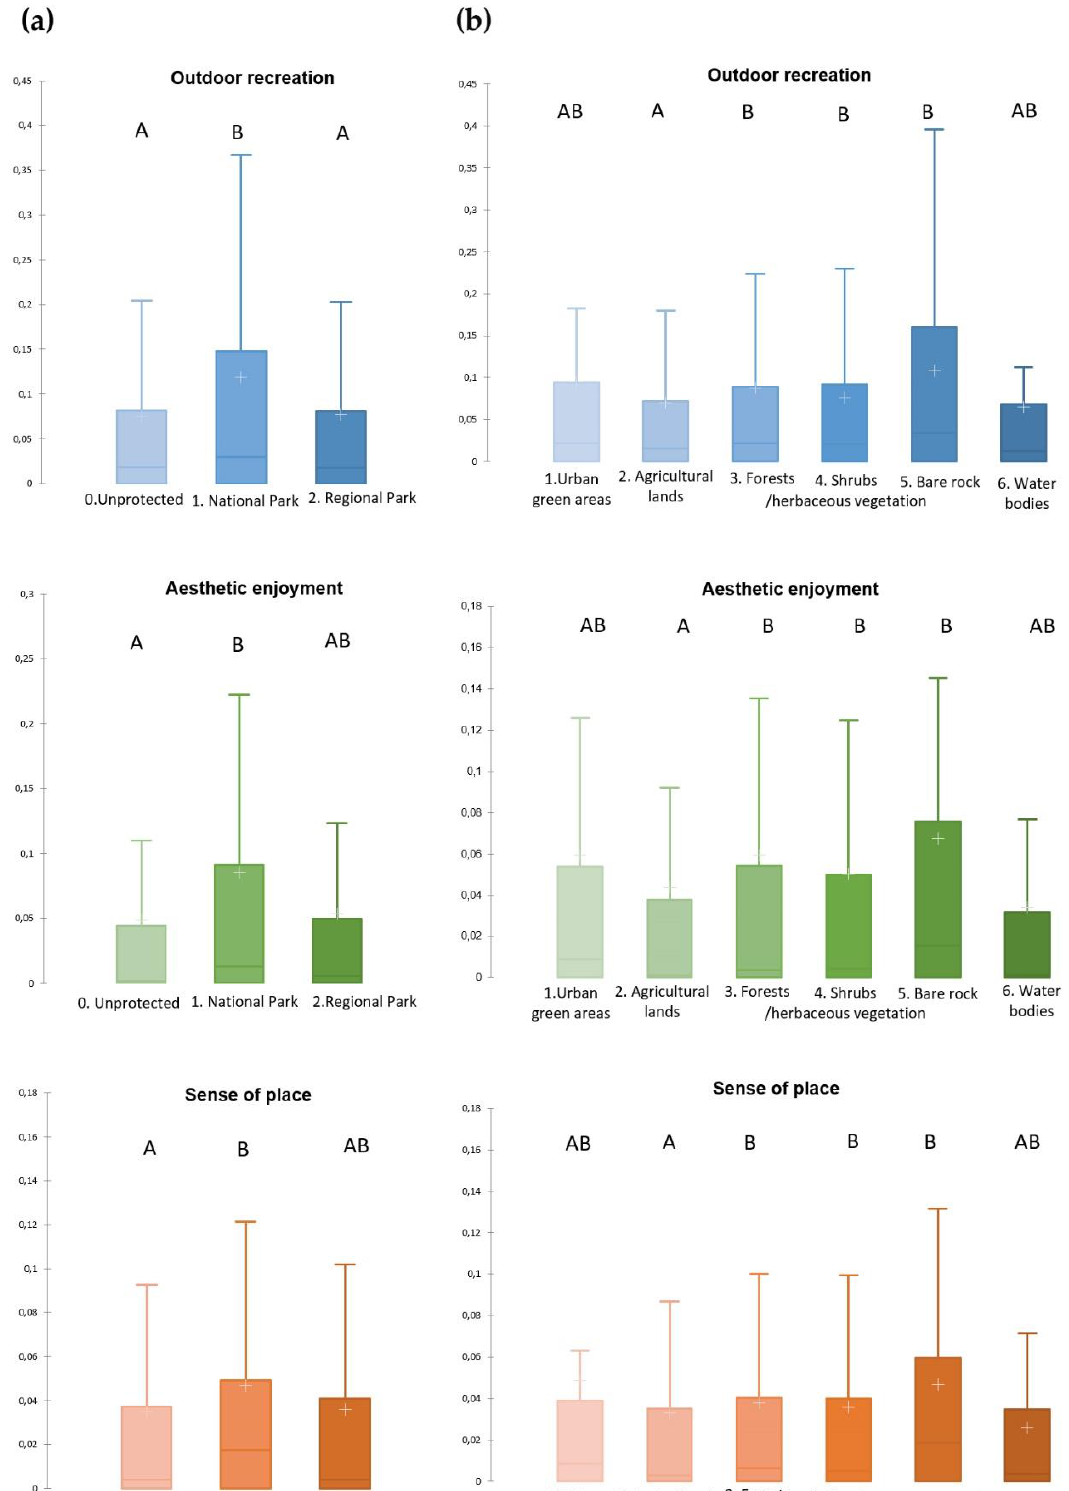
Figure 4. Relationship between the mapped supply of CES and categories of ( a ) natural protected areas and ( b ) CORINE land-use/land-cover classes. Different letters indicate significant differences (Dunn test; p < 0.05).